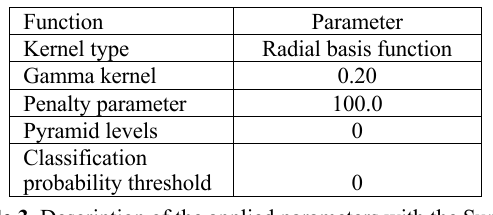
Table 3. Description of the applied parameters with the Support Vector Machine (SVM) classifier.